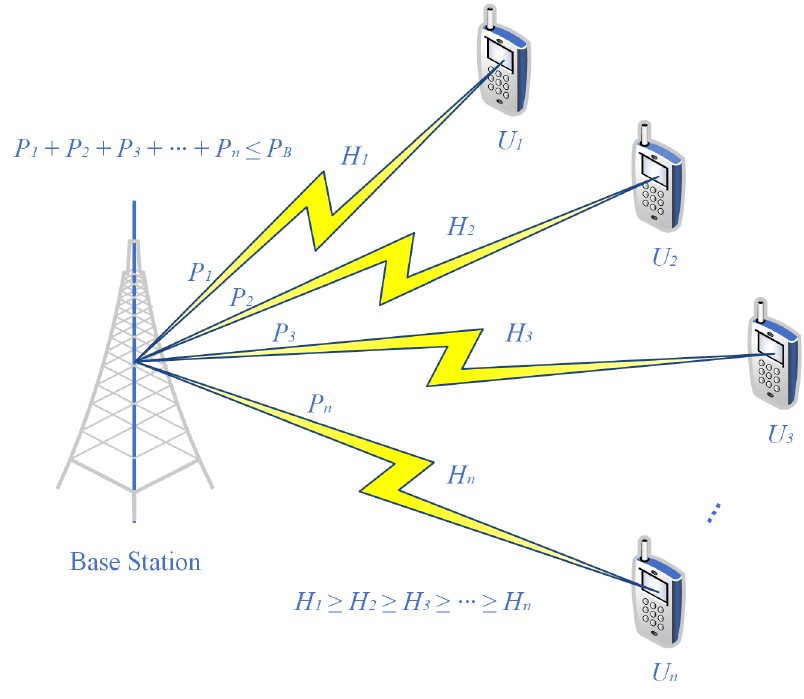
Figure 1. A downlink NOMA system